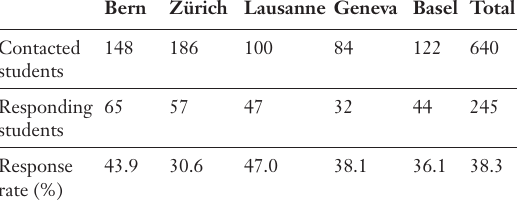
Response rates of the students’ survey.